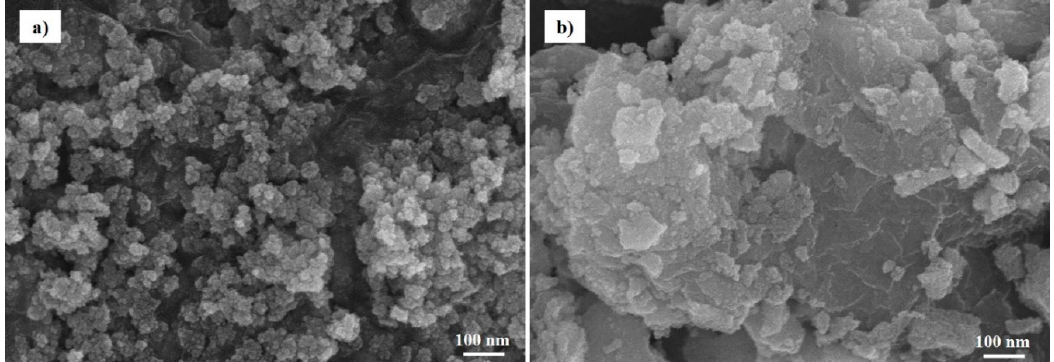
Figure 9. SEM images of the CNC–SnO 2 NF800 electrode ( a ) before and ( b ) after 200 cycles.